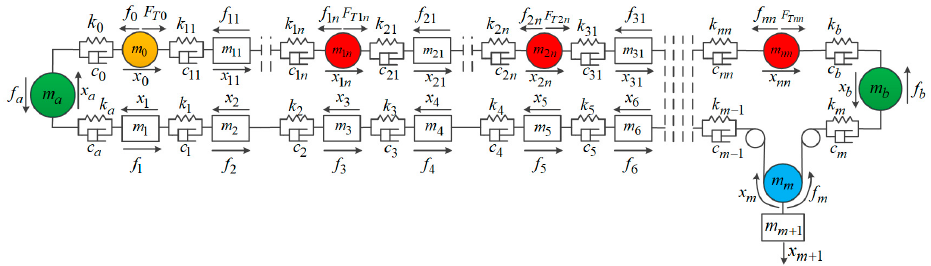
Figure 6. Discrete element model of mechanical load dynamics for distributed permanent magnet direct drive belt conveyor.